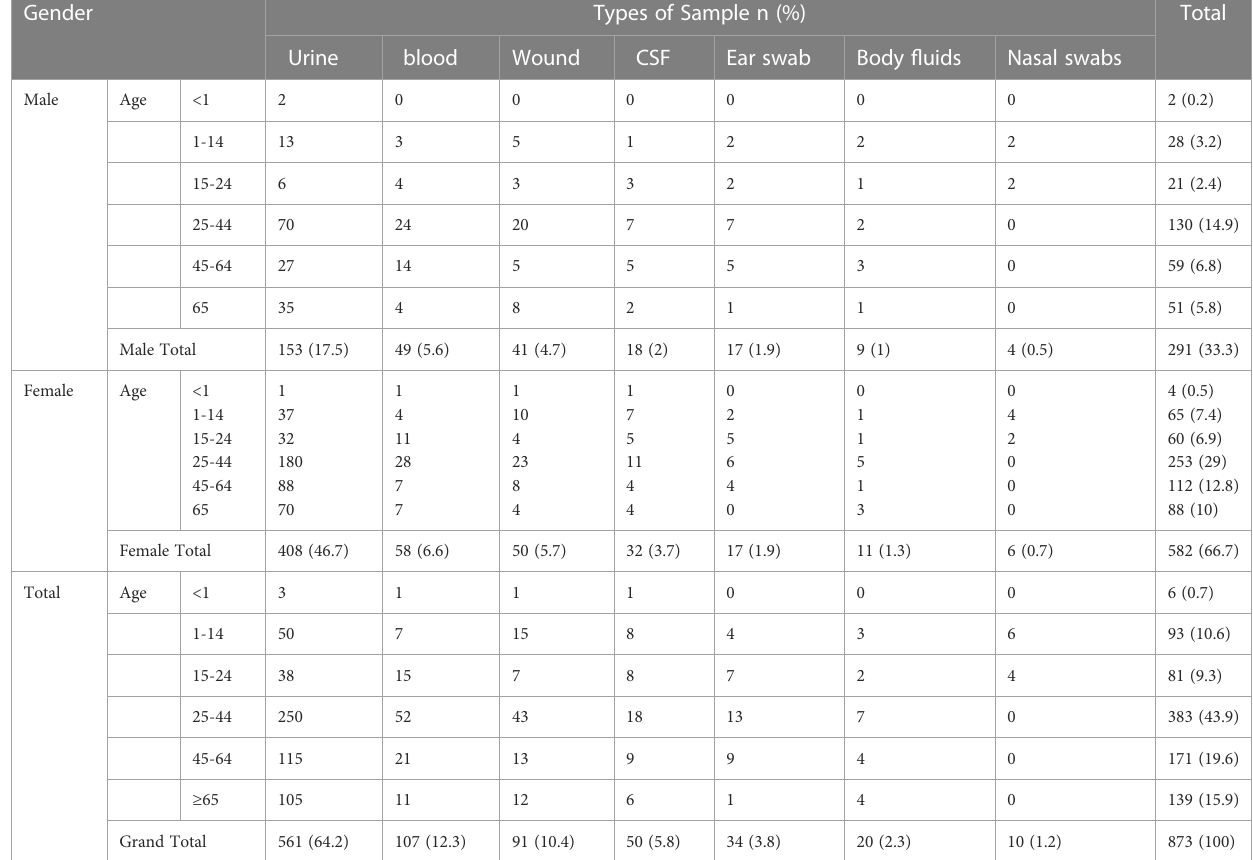
TABLE 1 Distribution of clinical samples according to sex and age of study subjects (n=873).